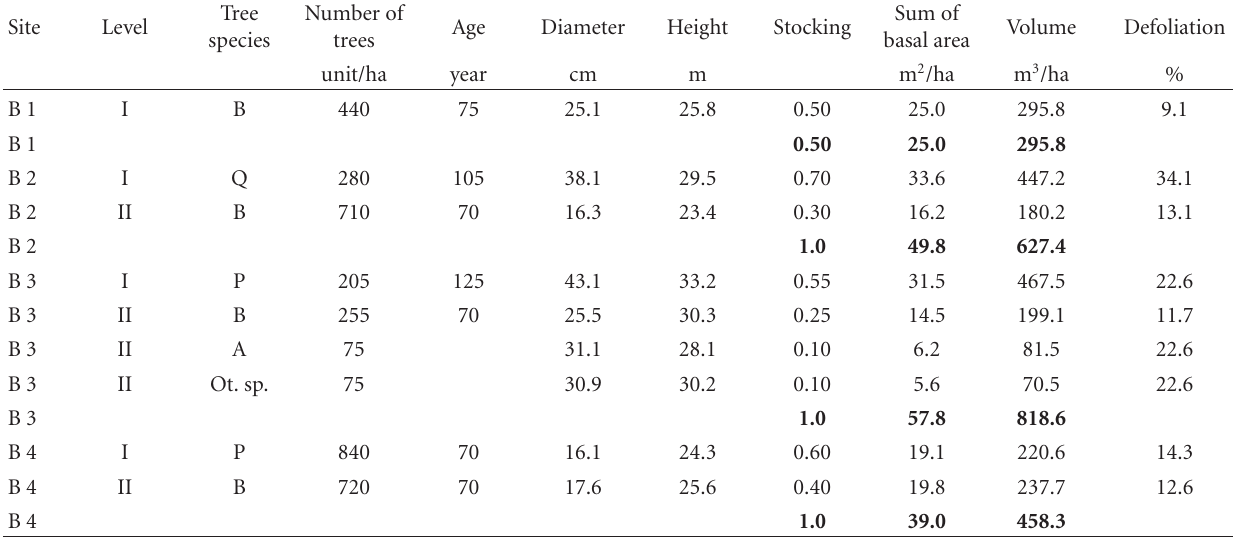
Table 1: Main dendrometric characteristics of the monitored stands. Diameter Height Stocking